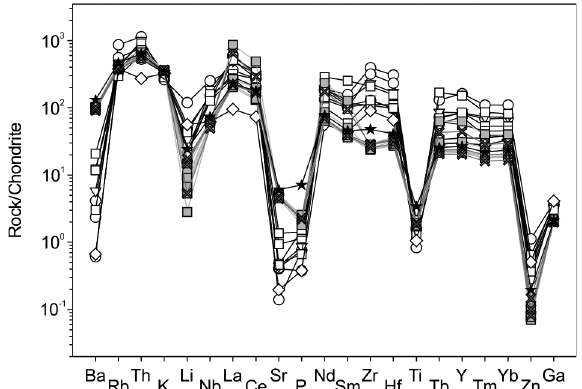
Figure 13 - Chondrite-normalized multi-element diagram showing relative enrichment and depletion patterns for selected samples from the Quiriri and Papanduva plutons, Morro Redondo Complex. Normalizing factors after Thompson (1982), plus Li, Zn and Ga after McDonough and Sun (1995). Symbols as in Fig.